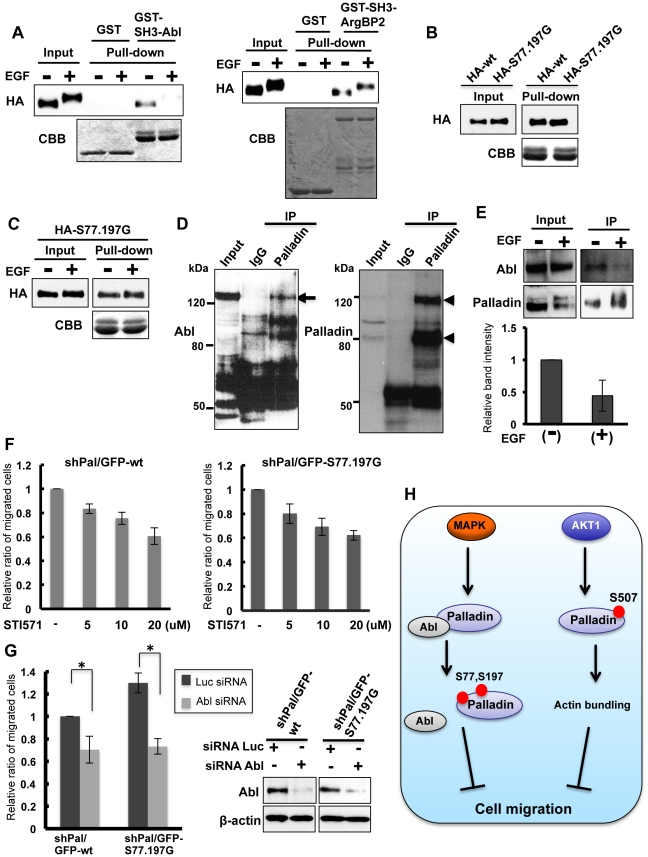
Phosphorylation of Ser77 and Ser197 regulates palladin association with Abl.(A) Serum-starved 293T/HA-wt cells were either stimulated or non-stimulated with EGF for 5 min, and cell lysates were affinity precipitated with the indicated recombinant proteins (SH3-Abl; aa66–118, SH-ArgBP2; aa432–666). Lower panels show the Coomassie blue staining of recombinant proteins. (B) HEK 293T cells were transfected with either HA-tagged palladin (HA-wt) or HA-tagged S77.197G palladin (HA-S77.197G). Twenty-four hours later, cells were lysed and affinity precipitated with GST-SH3-Abl protein bound to glutathione agarose. Immunoprecipitates were blotted with anti-HA antibody. Lower panel shows the Coomassie blue staining of the GST-SH3 Abl protein. (C) Serum-starved 293T/HA-S77.197G cells were either stimulated or non-stimulated with EGF for 5 min, and cell lysates were affinity precipitated with GST-SH3-Abl protein bound to glutathione agarose. Immunoprecipitates were blotted with anti-HA antibody. (D) MDA-MB-231 cells were lysed and immunprecipitated with either control IgG or anti-palladin antibody. The lysates were blotted with anti-Abl or anti-palladin antibody. The arrow indicates Abl and the arrowheads indicate palladin. The band around 140 kDa is an alternative form of palladin. (E) MDA-MB-231 cells were serum-starved and stimulated with or without EGF and lysed for immunopreciptation. The lyates were blotted with anti-Abl and anti-palladin antibodies. The graph shows the relative band intensity of immunoprecipitated Abl from three independent experiments. (F) Migration of shPal/GFP-wt and shPal/GFP-S77.197G cells (MDA-MB-231) was examined in the presence of indicated concentrations of STI571. Relative ratio of migrated cells was normalized by the number of migrating cells in the absence of STI571. Three independent experiments were performed and the data are shown as mean ±SD. (G) shPal/GFP-wt and shPal/GFP-S77.197G cells (MDA-MB-231) were transfected with either luciferase (Luc) or Abl siRNA and 48 h later, cell migration was examined. Relative ratio of migrated cells was normalized by the number of migrating shPal/GFP-wt cells transfected with Luc siRNA. Three independent experiments were performed and the data are shown mean ±SD (*P<0.01). Expression of Abl after siRNA transfection was examined by immunoblot. (H) Schematic presentation of regulation of cell migration by palladin phosphorylation.